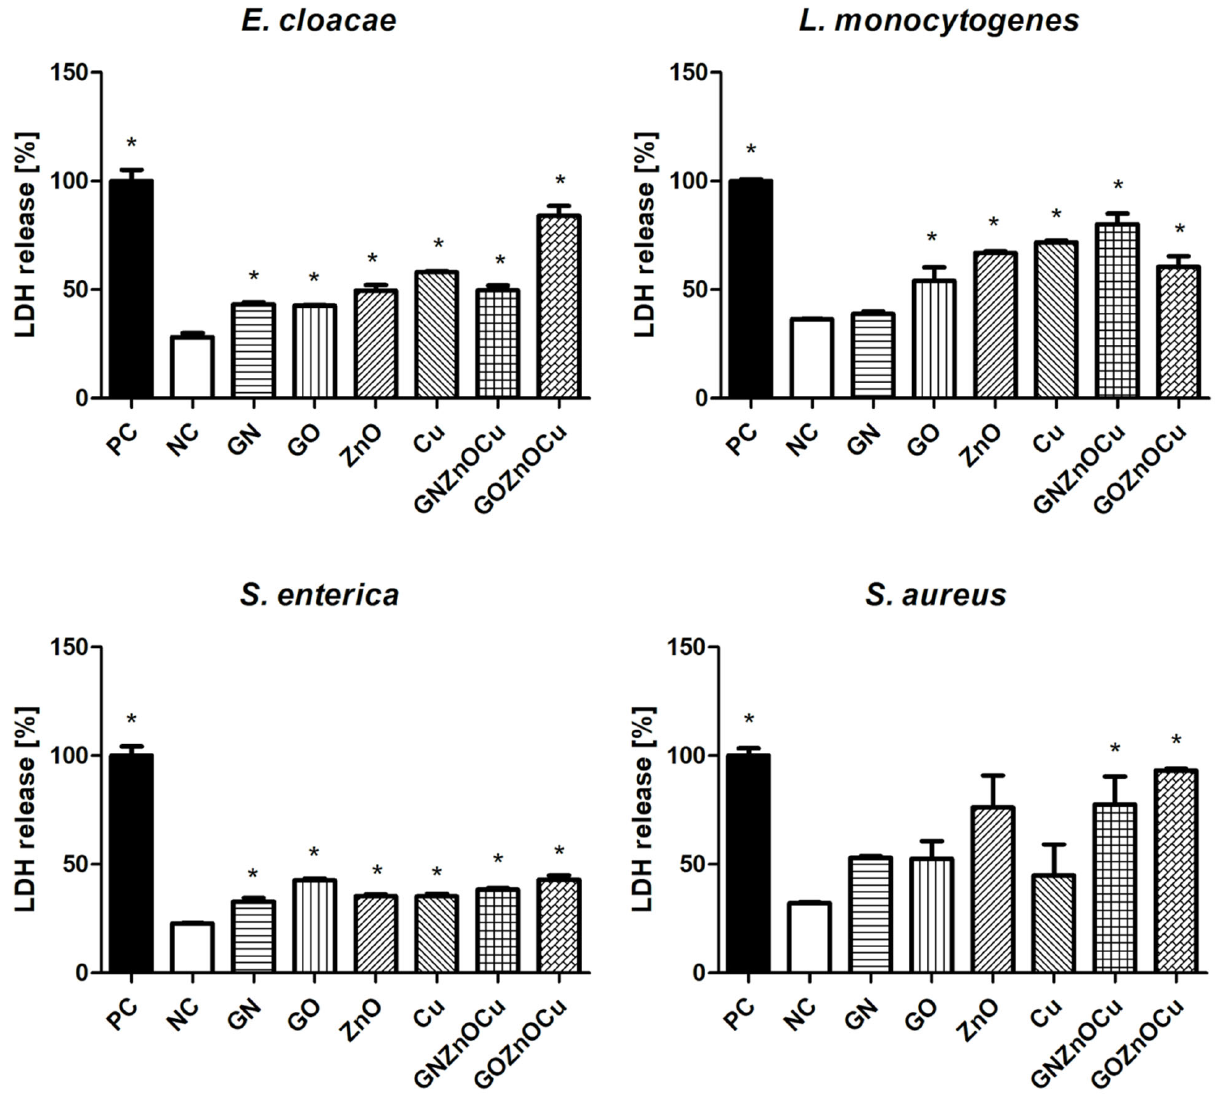
Figure 7. Bacteria LDH release after treatment with nanomaterials. PC signifies the positive control samples, while NC signifies the negative control samples, and the results are mean values ± standard deviation. “*” symbols indicate statistically significant differences in comparison to the